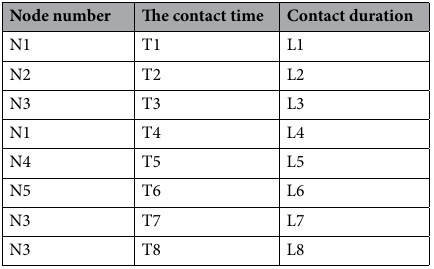
Table 1. Node contact information table.